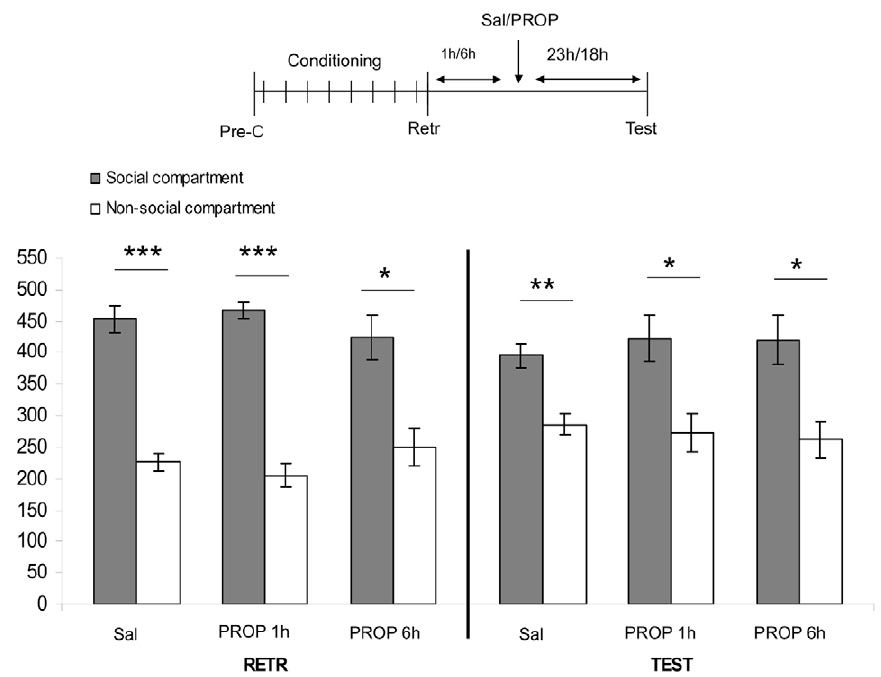
Figure 2. Effects of 1h and 6h delayed post-retrieval PROP on reconsolidation of social play-induced CPP. The experimental protocol is depicted above the graph (Pre-C: pre-conditioning test, CS + : conditioning session with a play-partner, CS-: conditioning session alone). Data represent the mean time (sec 6 SEM) spent in the social compartment (grey bars) and the non-social compartment (white bars) during 15 min retrieval- (RETR) and test- (TEST) sessions. Saline-treated animals (2 ml/kg, i.p ., n=17), 1 h delayed PROP-treated animals (10 mg/kg, i.p ., n=13), 6 h delayed PROP-treated animals (10 mg/kg, i.p., n=10). Post-hoc Student’s paired t-tests for difference in time spent in the social- and non-social compartment *p , 0.05, **p , 0.01, ***p , 0.001.